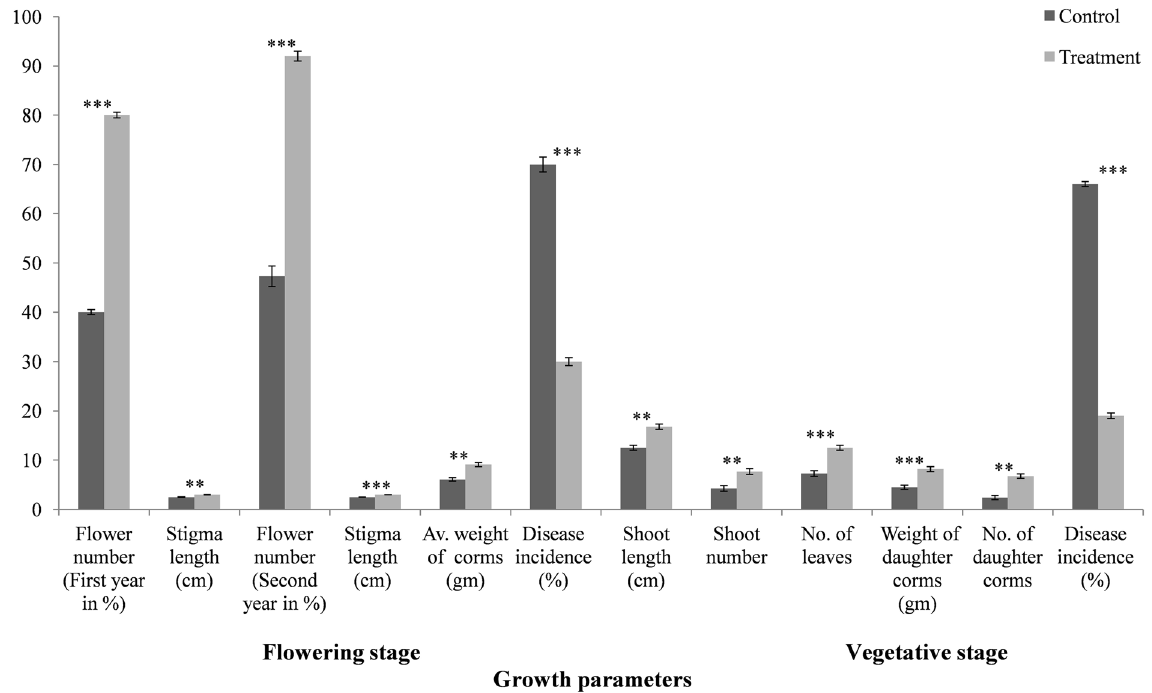
Figure 5. Evaluation of Bar D5 based bioformulation in the fields during the flowering and vegetatitive stage of saffron life cycle. Results are the average of ten replicates and experiments were performed in triplicates. Error bars represents the standard deviation. Corresponding results of ANOVA: *** represents the highly significant difference between means of control and treatment as P value (< 0.001), ** represents significant difference as P value (<